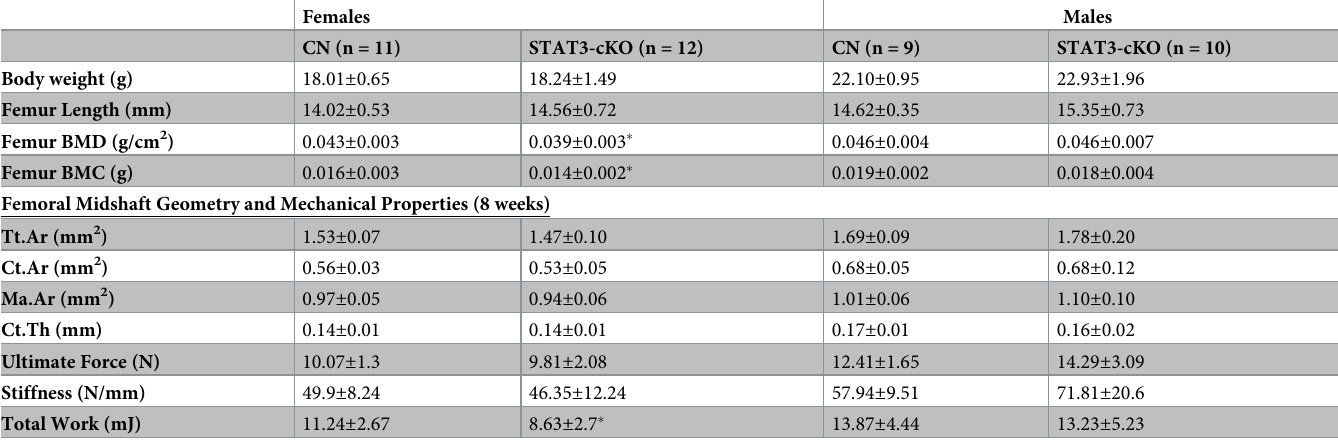
Table 1. Body weight, femoral geometry, mineral content and density, and mechanical properties in 8 week old male and female STAT3-cKO mice and their litter- mate controls (CN).